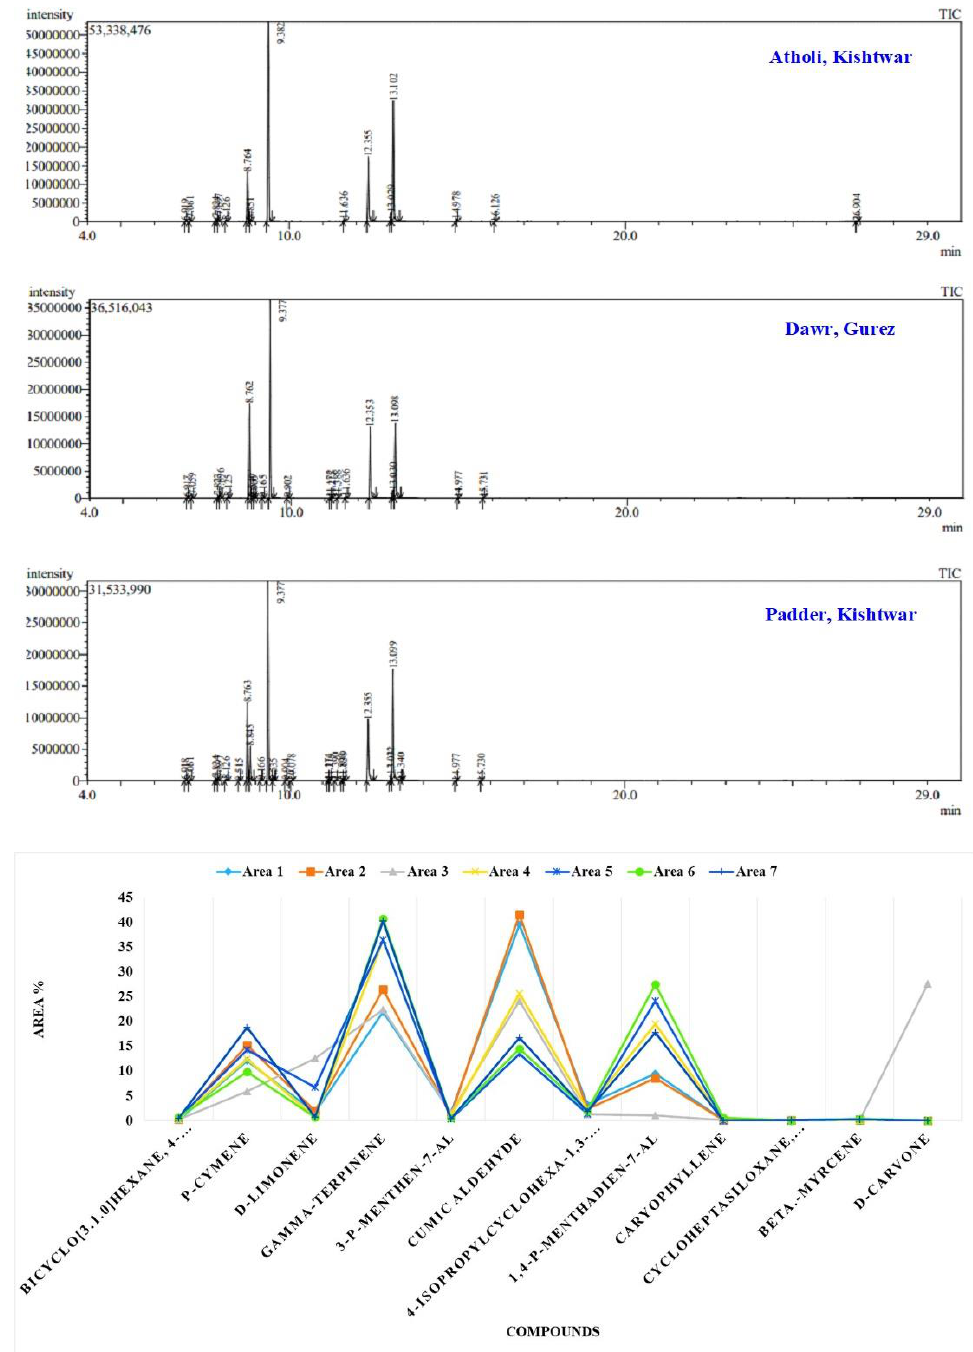
Figure 1 . Figure showing the chemical composition and variability of essential oils ( X -axis) in B. persicum collected from seven different geographical locations as area percent ( Y -axis).